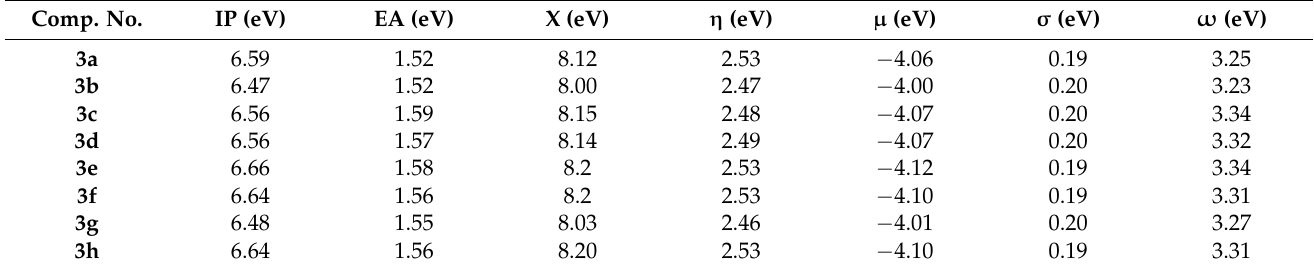
Table 8. Theoretically calculated global reactivity parameters of compound 3a – 3h